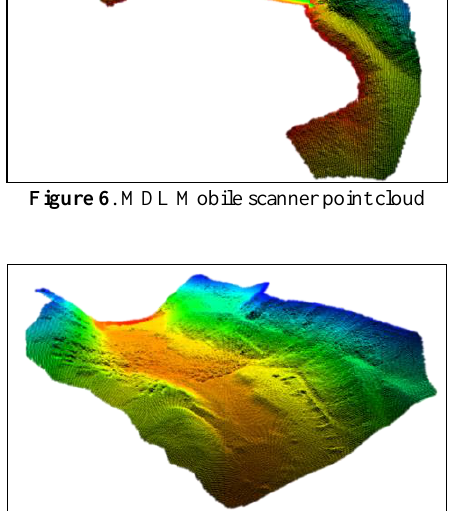
Figure 7 . Point cloud obtained by the multi-beam